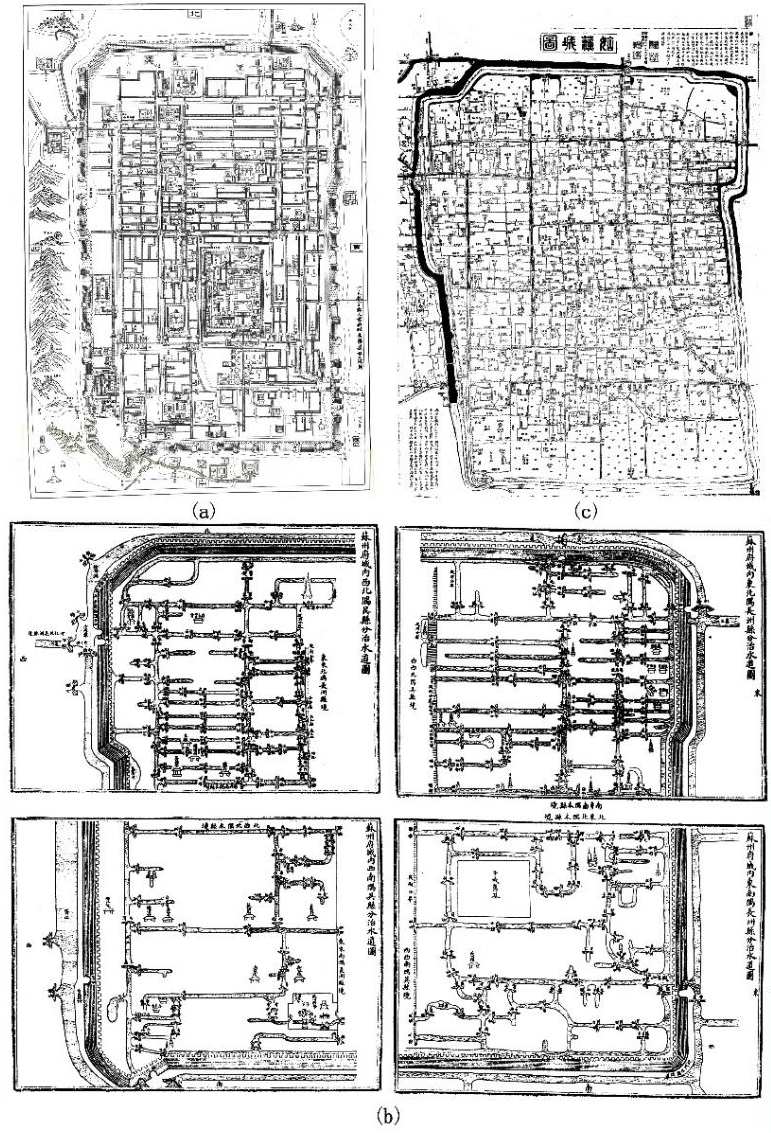
Figure 2. Suzhou ancient maps of the Song, Ming and Qing Dynasties. ( a ) Map of Pingjiang in the Song Dynasty. ( b ) Map of Suzhou inland canals in the Ming Dynasty. ( c ) Map of Gusu city in the Qianlong Period of Qing